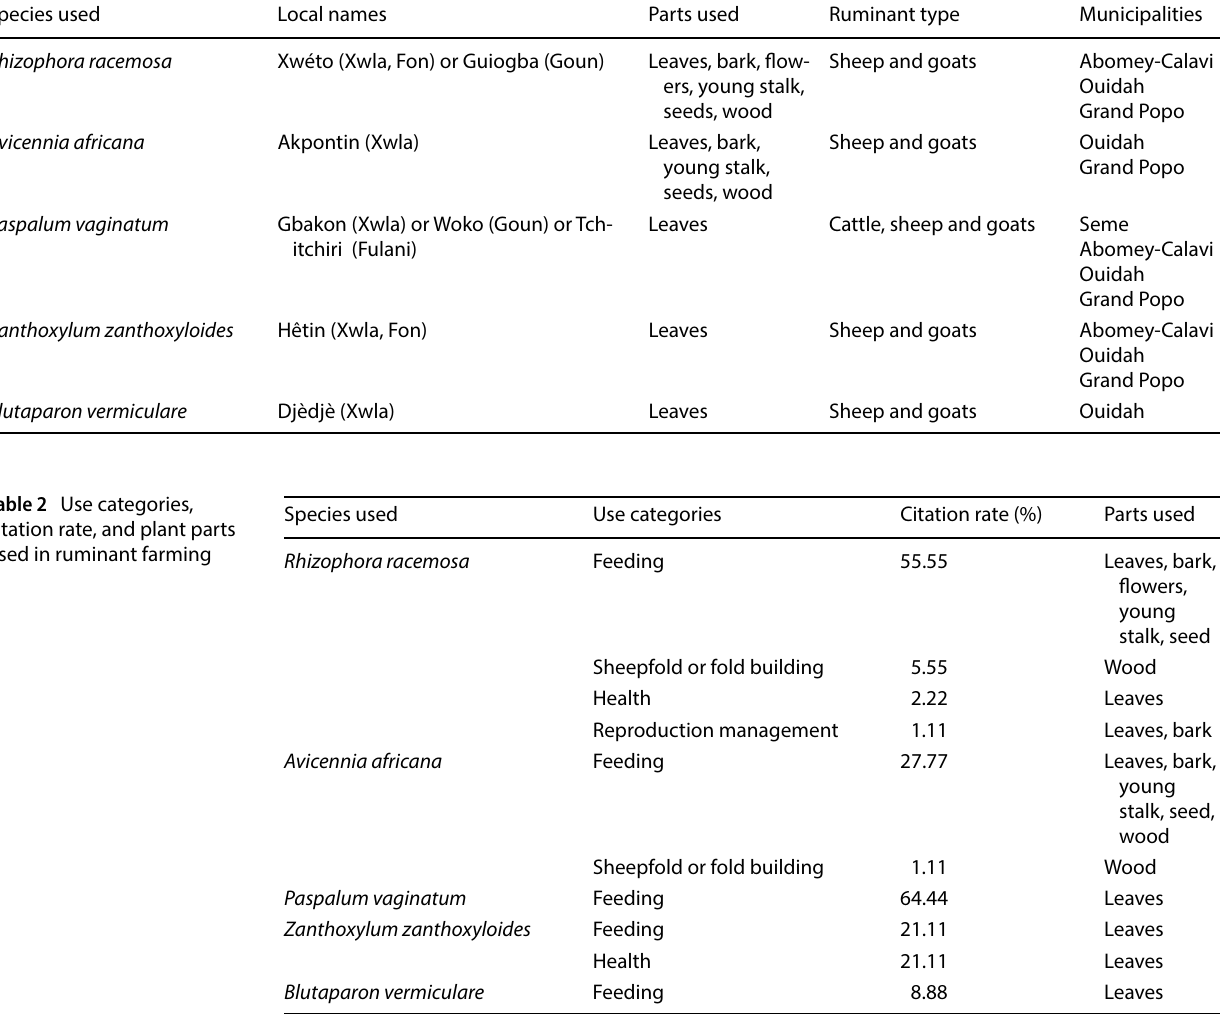
Table 1 Use of mangrove species in ruminants keeping in the different municipalities Species used